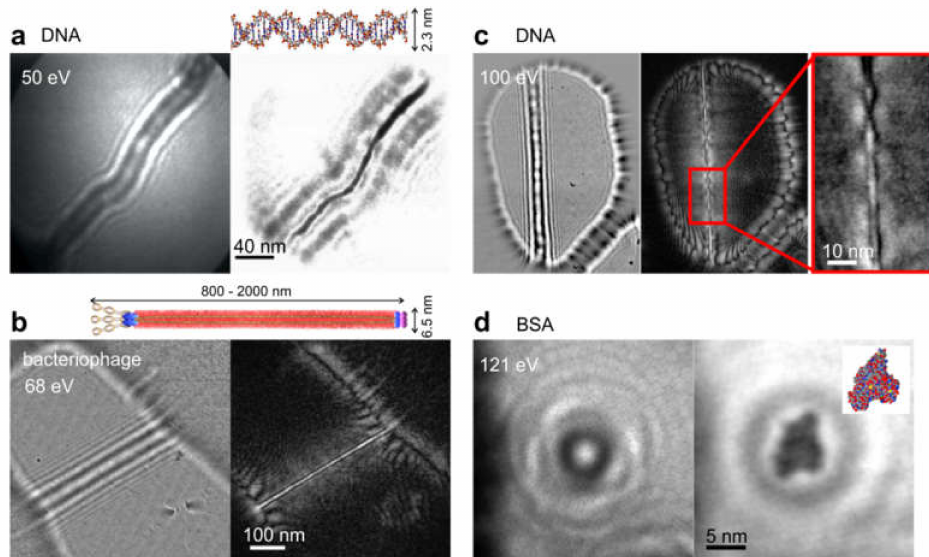
Figure 20. Low-energy in-line holography imaging of individual macromolecules, showing results obtained by Fink et al. University of Zurich. In each case, the left image shows experimental holograms and the right shows the corresponding reconstructions: ( a ) DNA molecules, copyright OSA 1997 [38], ( b ) bacteriophage molecule (reprinted by permission from Springer Nature [90], copyright 2011), ( c ) DNA molecule [87] (copyright Springer Nature 2013), and ( d ) bovine serum albumin (BSA) molecules [92].